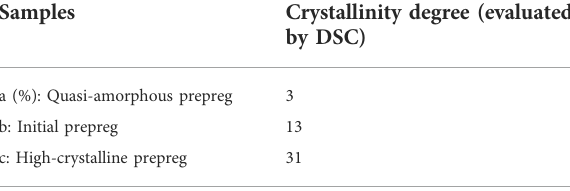
TABLE 2 Crystallinity degrees of three different prepreg